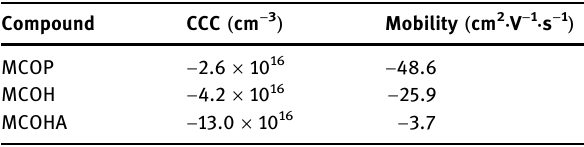
Table 5: Electrical properties of the MCO